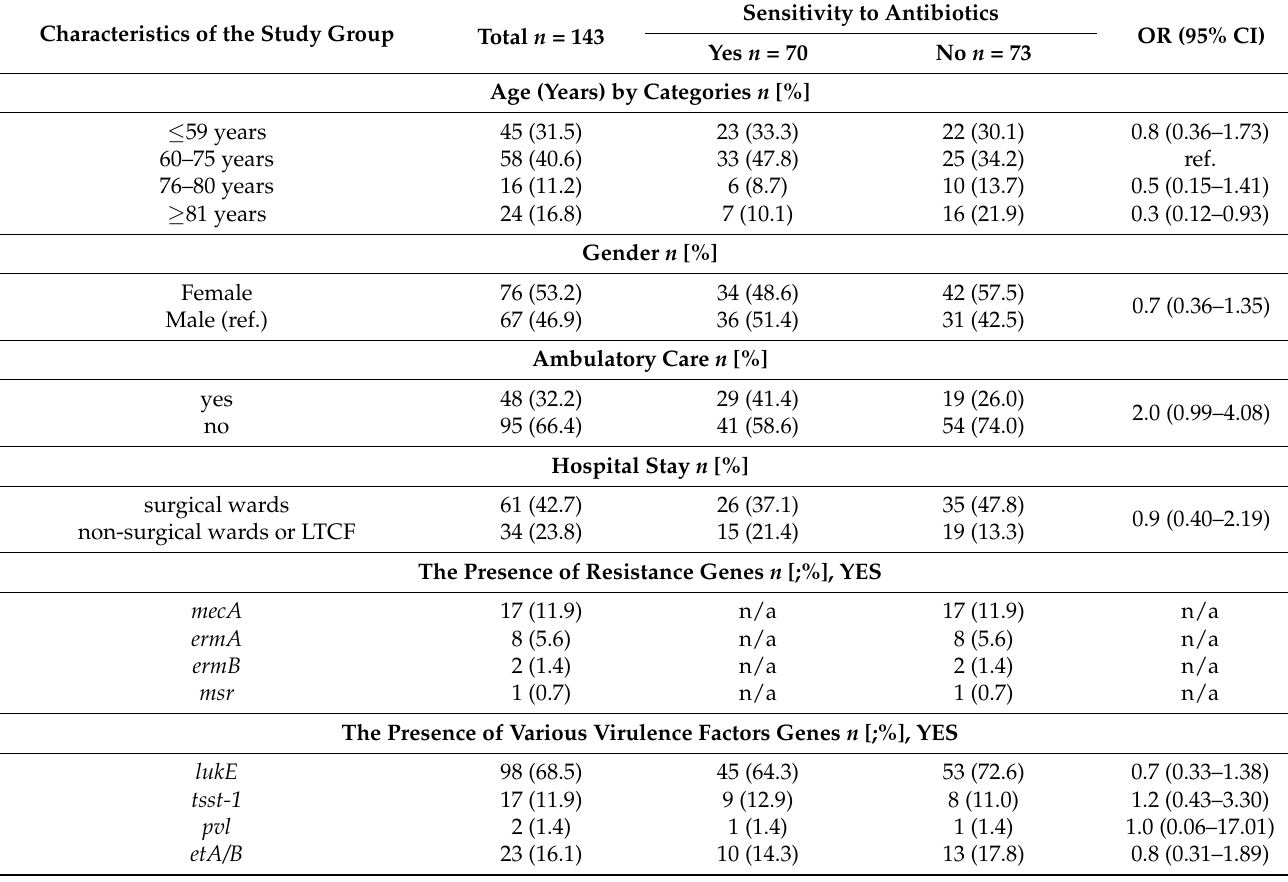
Table 2. Characteristics of the study group according to drug sensitivity of Staphylococcus aureus. Characteristics of the Study Group Total n =